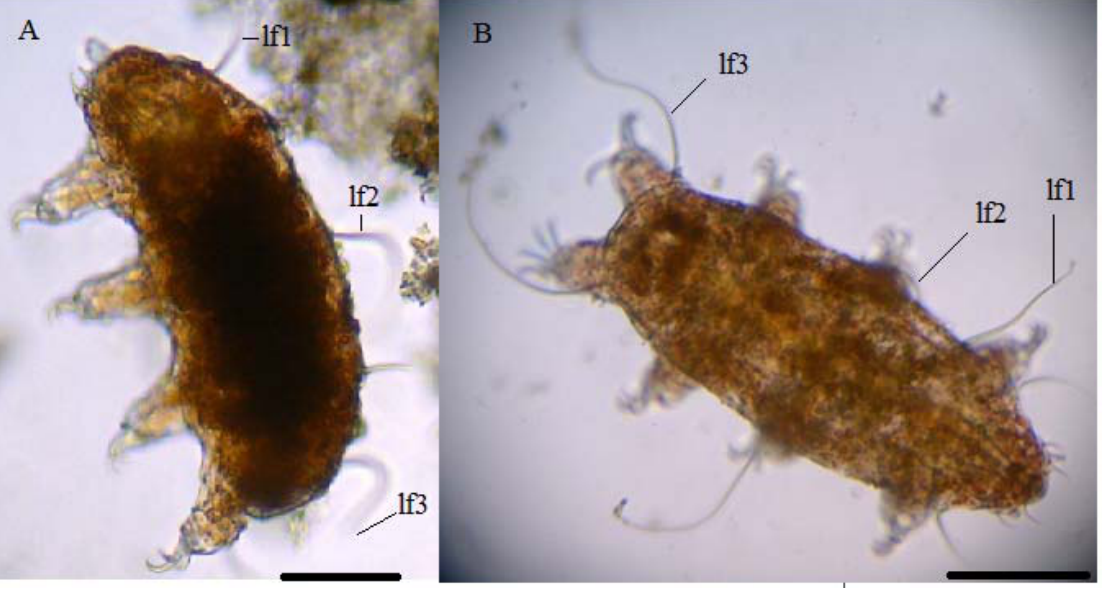
F IGURE 3. General morphology of E. testudo . Scale bars equal 25 μ m (A) lateral view of lateral filaments of this species. (B) Dorsal view of lateral filaments in E. testudo . (lf: lateral filaments).